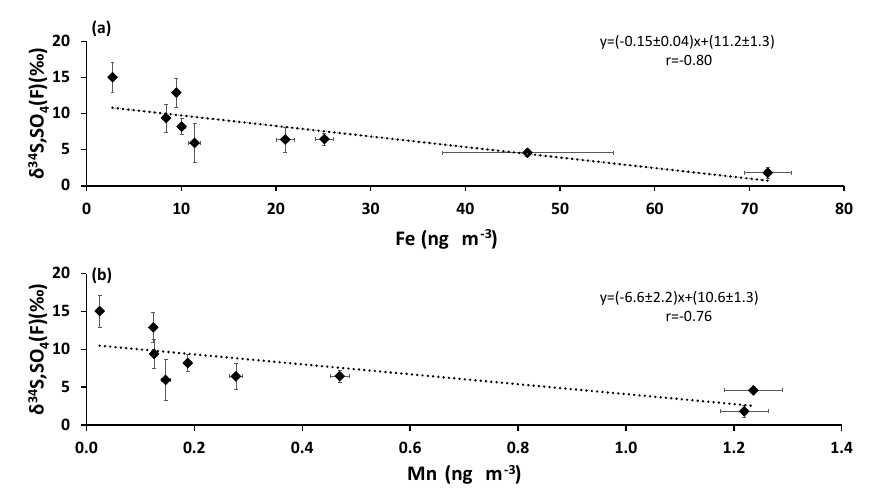
Figure 7. δ 34 S values of size F D< 0 . 49µm sulfate aerosols versus the concentrations of (a) Fe and (b) Mn.